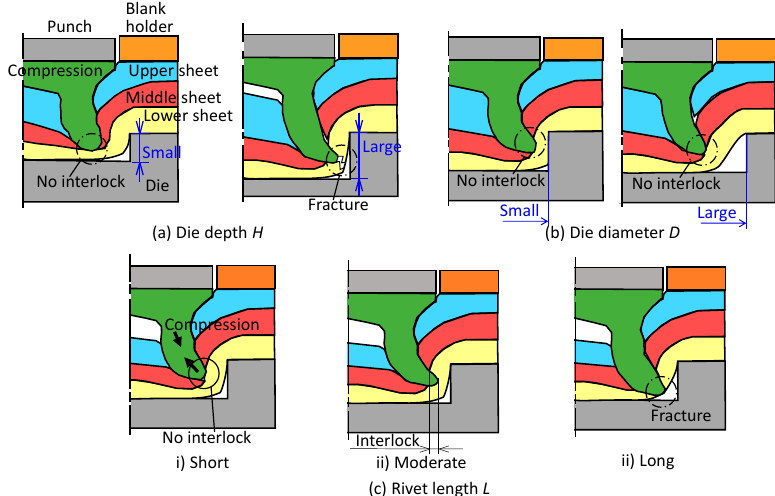
Figure 3. Effects of die shape and rivet length on the deforming behavior of sheets and rivets in the self-pierce riveting of three sheets: ( a ) die depth H ; ( b ) die diameter D ; ( c ) rivet length L .